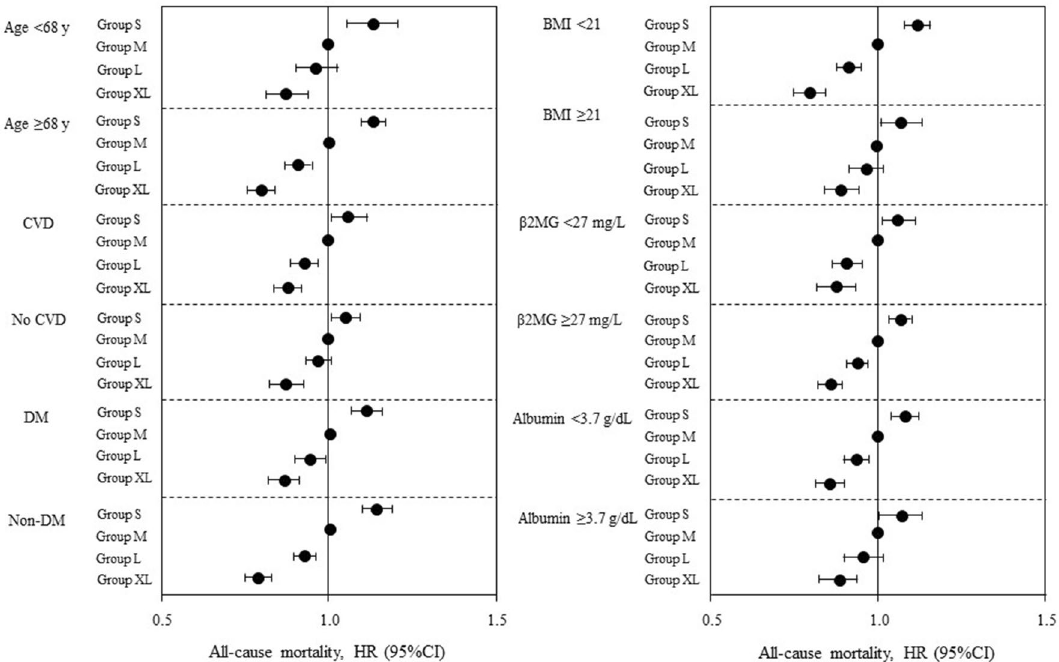
Figure 4. Sensitivity analyses of the association between dialyzer surface area and all-cause mortality stratified by median values for age, body mass index, β2-microglobulin, serum albumin, and comorbid cardiovascular disease and diabetes mellitus at baseline. Circles indicate the adjusted hazard ratio (HR) for mortality and the error bars indicate the 95% confidence interval (CI). The HR for mortality (95% CI) was derived from Cox proportional hazards models adjusted for all covariate values, including basic factors, dialysis-related factors, and nutrition- and inflammation-related factors. S group, small dialyzer surface area, < 1.5 m 2 ; M group, medium dialyzer surface area, 1.5 m 2 ; L group, large dialyzer surface area, 1.6 to < 2.0 m 2 ; XL group, extra-large dialyzer surface area, ≥ 2.0 m 2 . β2MG , β 2 -microglobulin; BMI body mass index, DM diabetes